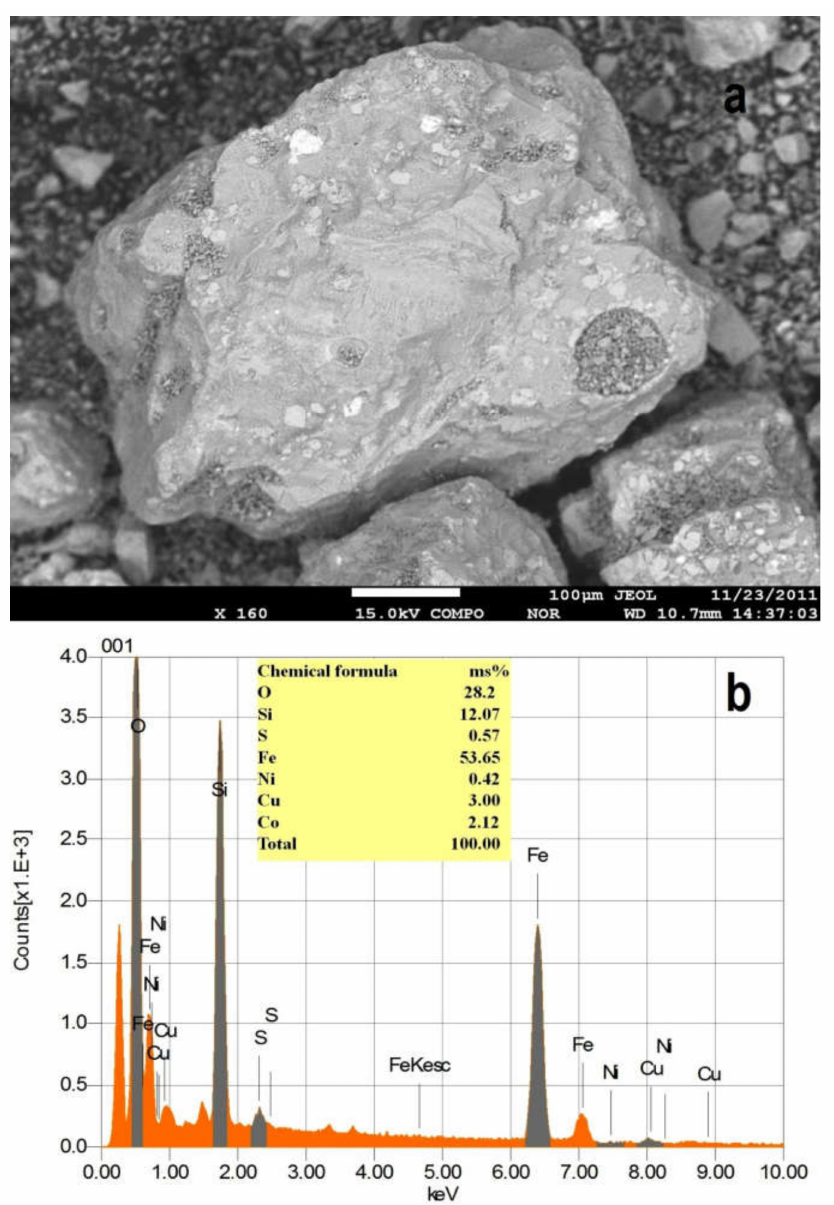
Figure1. ElectronProbeMicroAnalysis(EPMA)-EDAX(energy-dispersiveX-rayspectroscopy)(JX-8530, JEOL ™ , Tokyo, Japan) of converter slag overall sample, ( a ) micrograph; ( b ) EDS spectra (ms%: mass